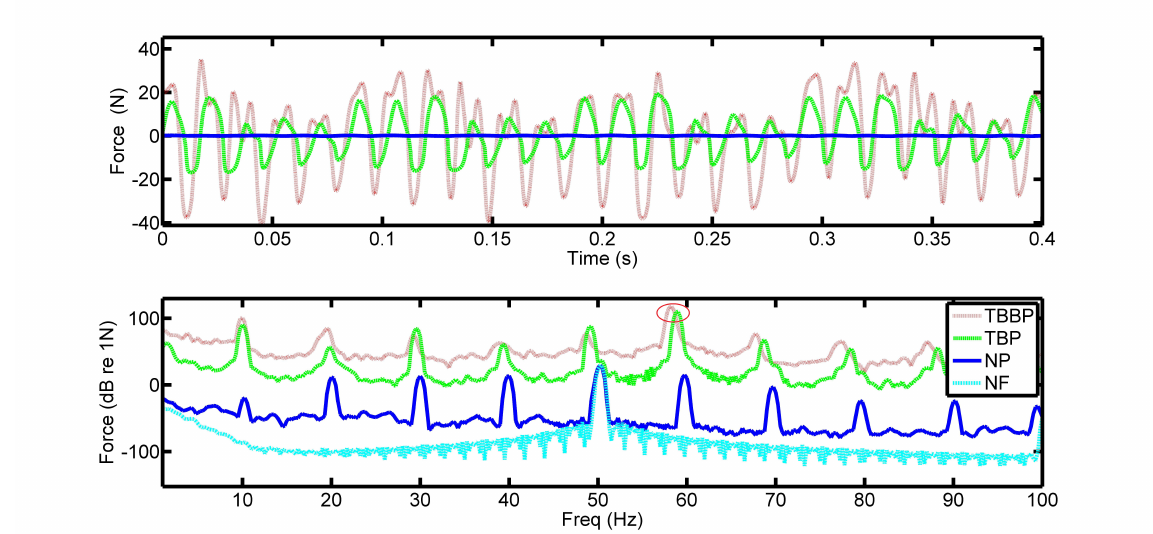
Figure 6. Captured force from the Polyvinylidene Fluoride (PVDF) with the two-blade propeller rotating at 600 RPM with a six pad bearing, time (top) and frequency (bottom) data. Where: